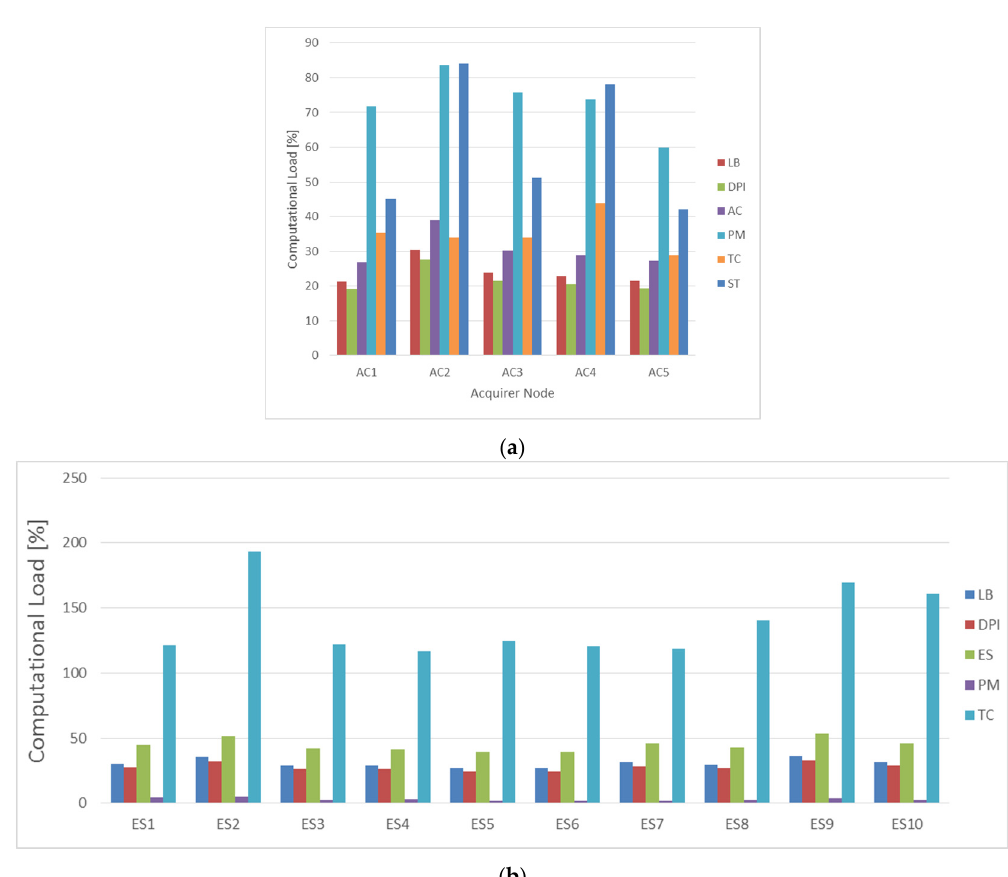
Figure 8. Per-block computational load. ( a ) computational load of each block in each acquirer; ( b ) computational load of each block in each edge streamer. TC: transcoder.